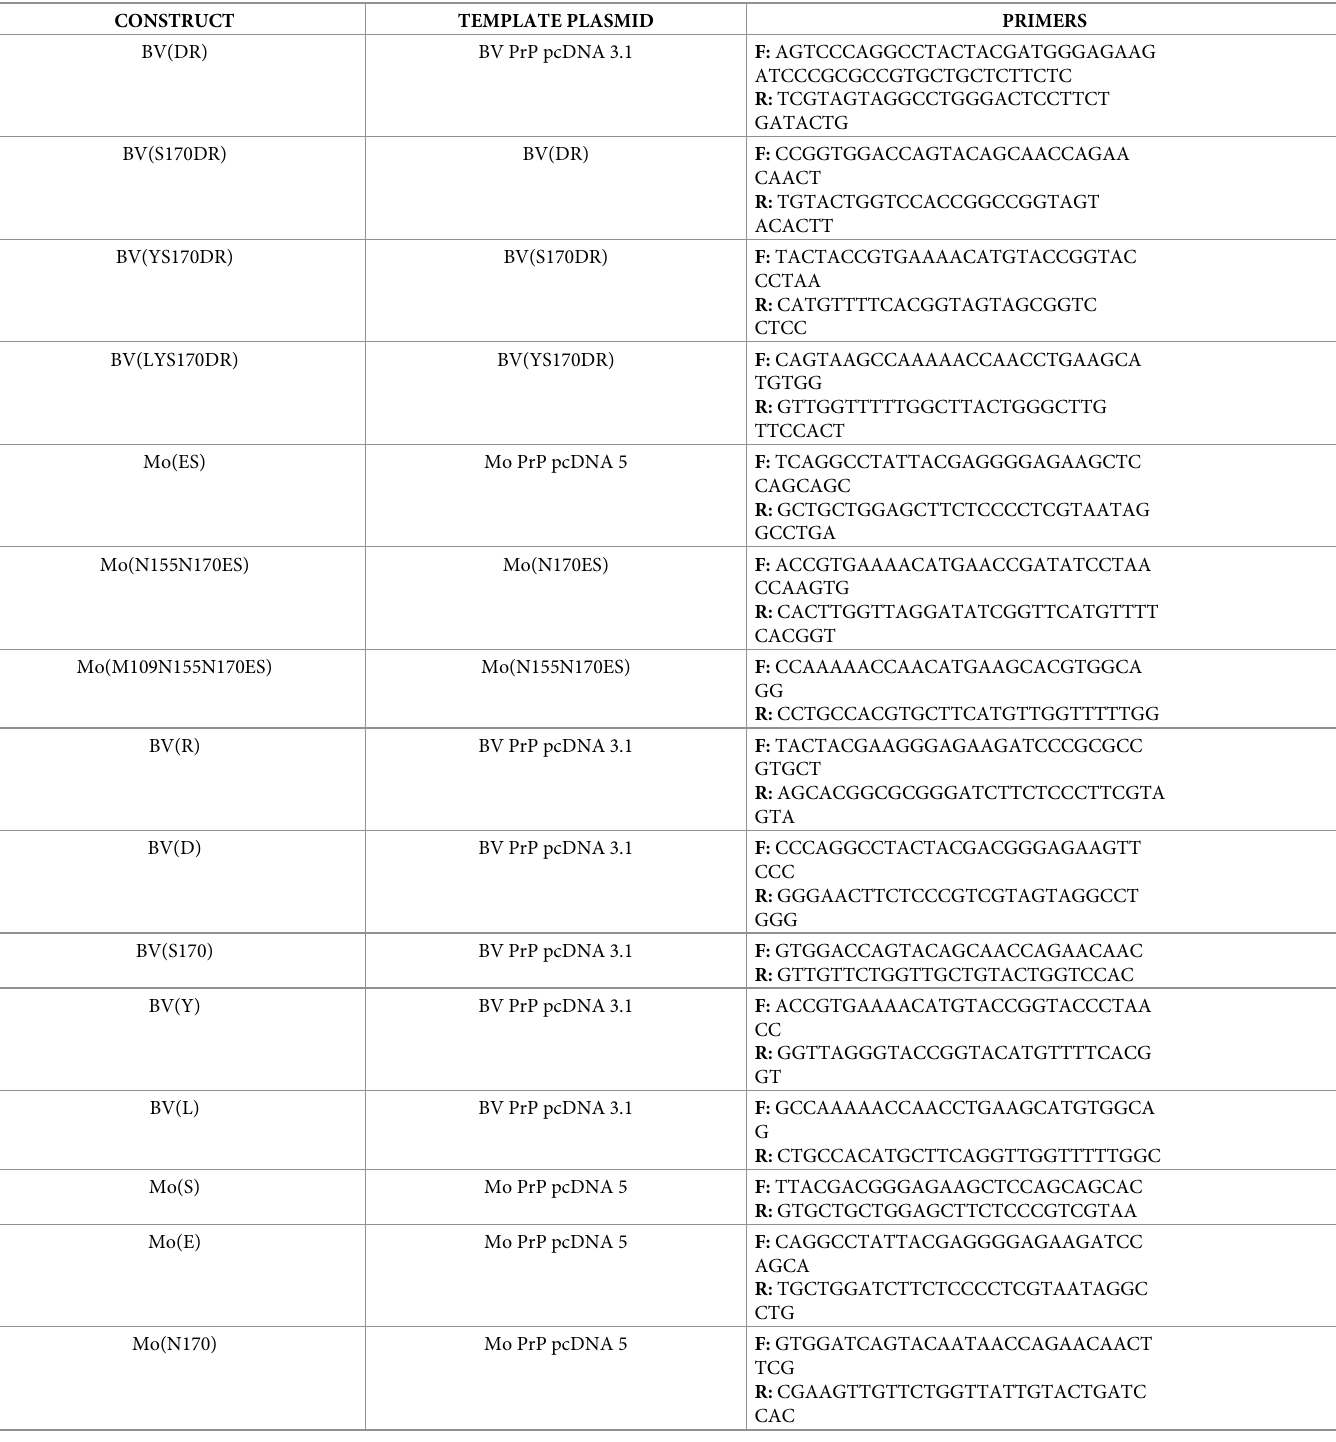
Table 1. Primers and template plasmids used to generate chimeric BV/Mo PrP